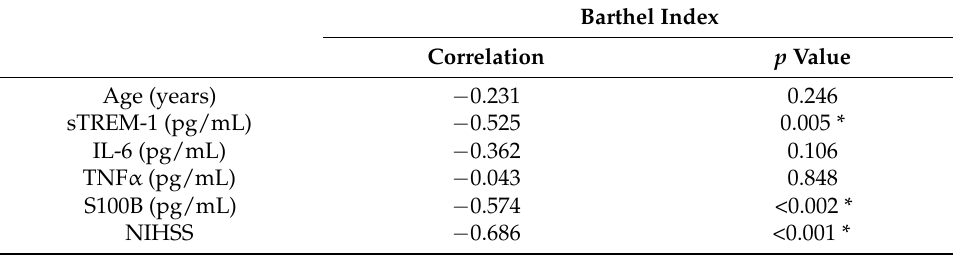
Table 4. Correlation between the Barthel index and age, sTREM, IL-6, TNF α , and S100B, and NIHSS.